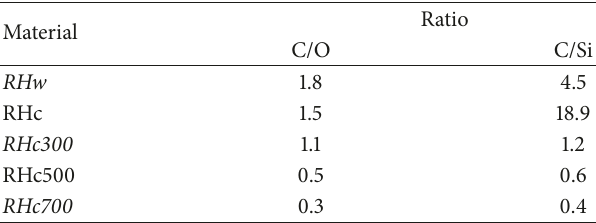
Table 3: C/O and C/Si ratios obtained by EDX analysis for all adsorbent